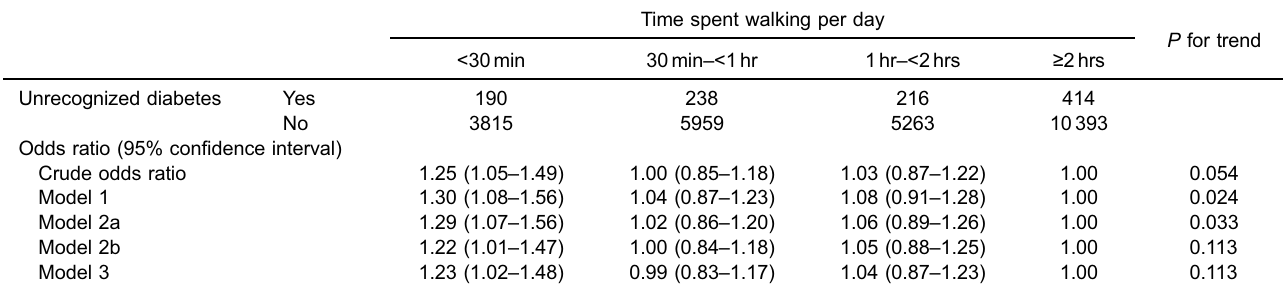
Time spent walking per